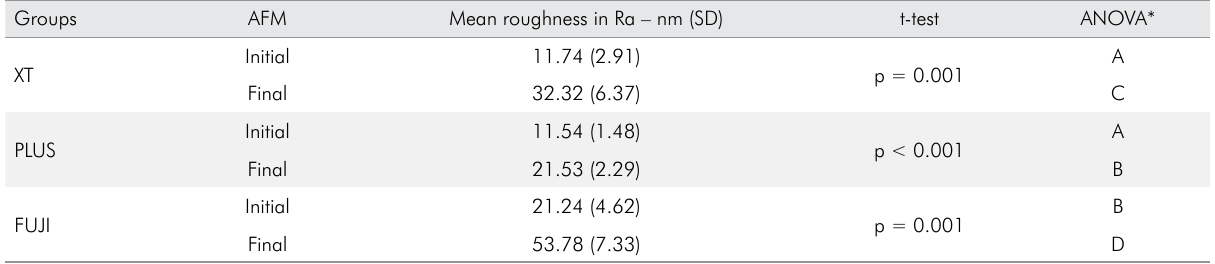
*Different letters express statistically significant different values (p <